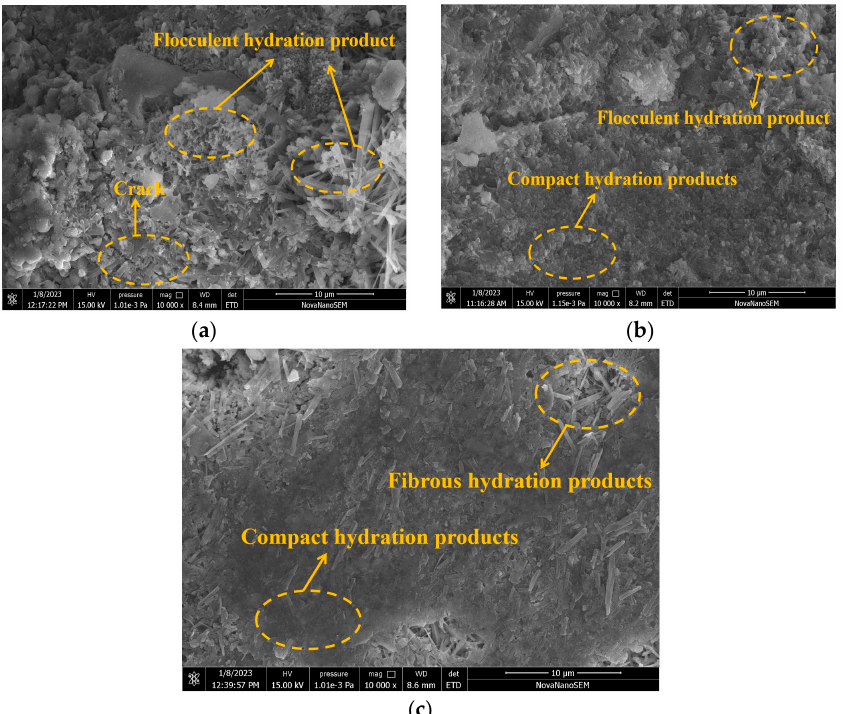
Figure 12. The SEM photos of RPC with incinerated waste fly ash. ( a ) RPC with incinerated waste fly ash ( b ) RPC with 50% carbonated incinerated waste fly ash. ( c ) RPC with 100% carbonated incinerated waste fly ash.